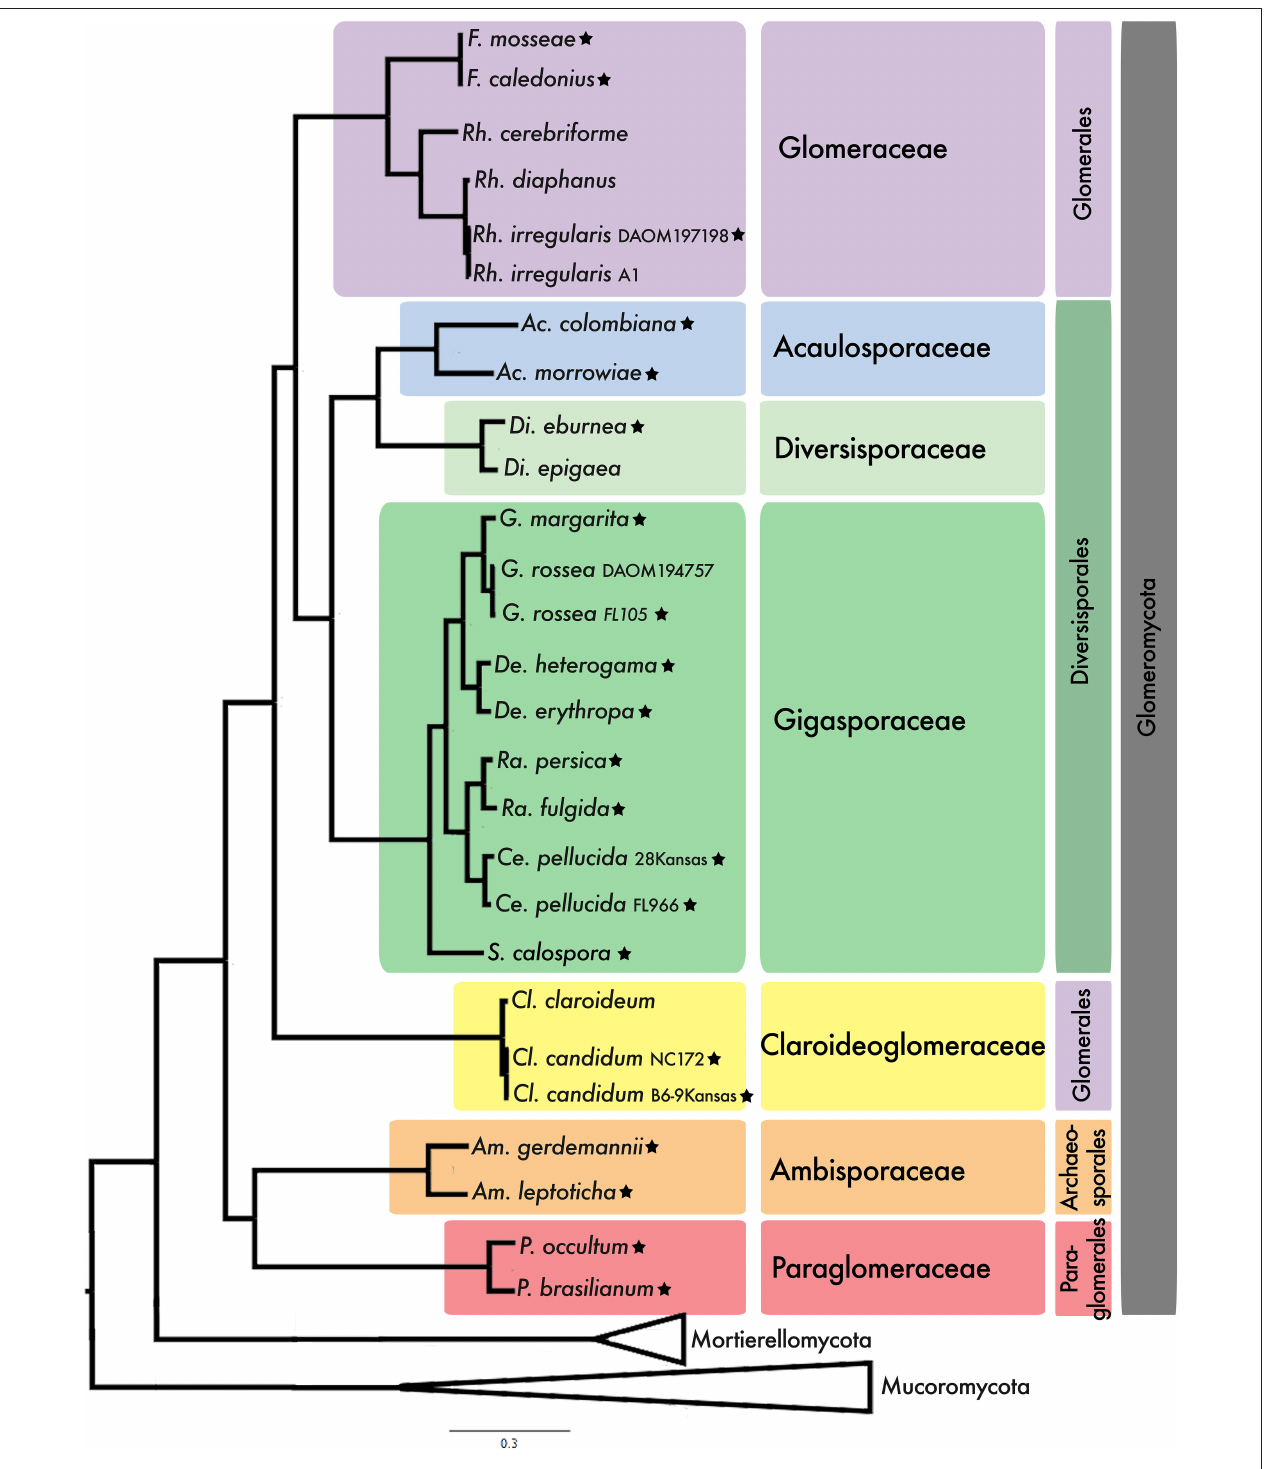
FIGURE 1 | Best maximum likelihood tree inferred with RAxML from a concatenated alignment of 371 single copy orthologs shared among > 50% of the taxa. The same topology was recovered using IQ-TREE and Bayesian inference. All nodes have a bootstrap support value of 100 in both analyses, and posterior probabilities of 1. Mucoromycota was used as outgroup. Stars following the taxon name mark newly sequenced strains from this study. Current taxonomic assignment based on Redecker et al. (2013) is color coded, at the levels of family and order. Strain identifers are included in the taxa label when more than one node has the same species name. See expanded tree in Supplementary Figure 7